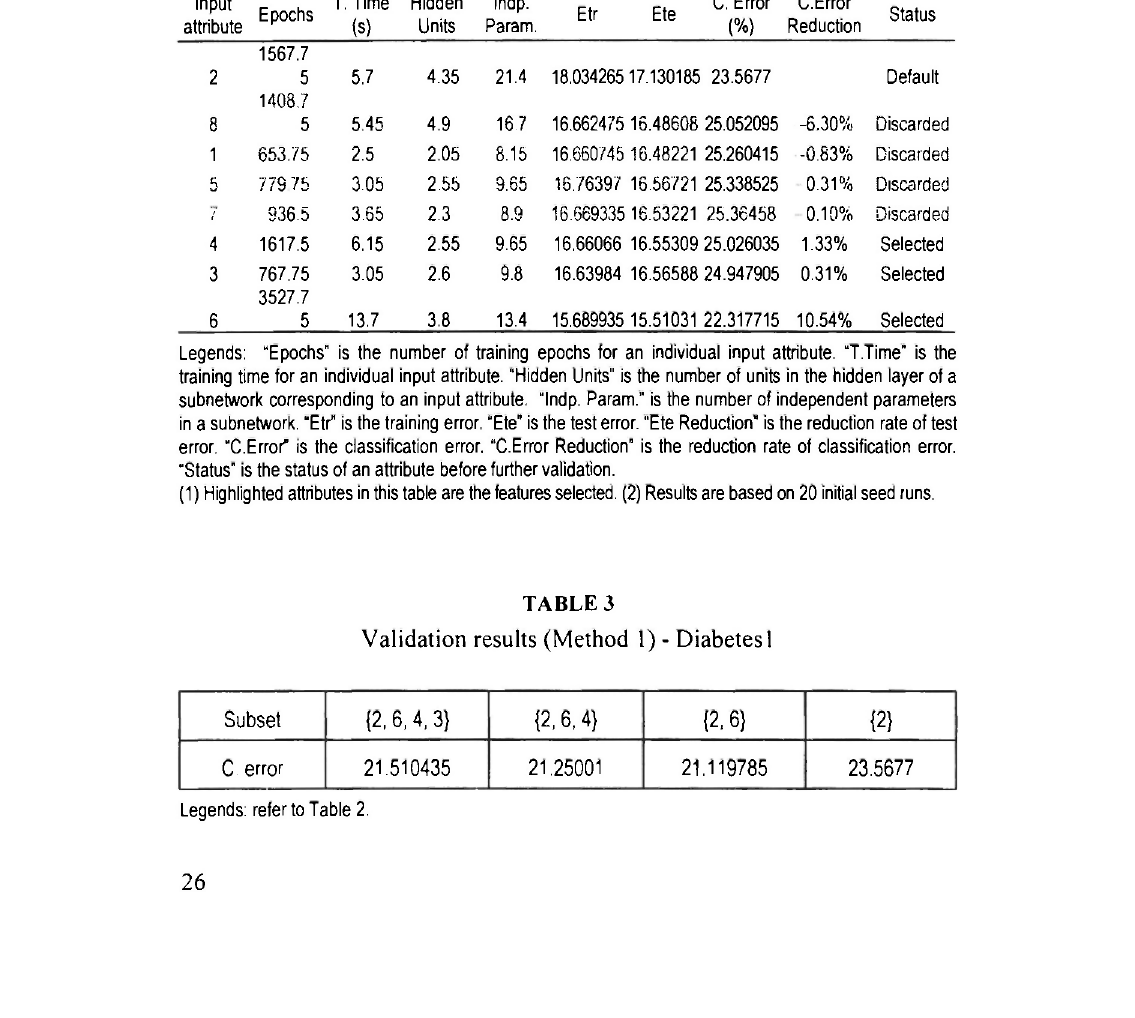
Ordered incremental training performance snapshot - Diabetesl